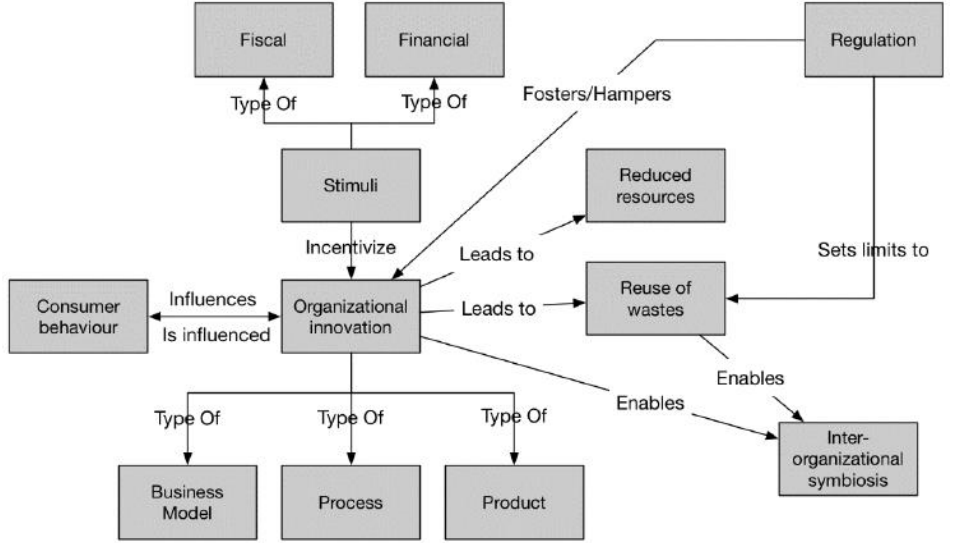
Figure 2. A meta-model scheme of inter-organizational cooperation and ES-CE coordination. Source: [82] p. 12/17.